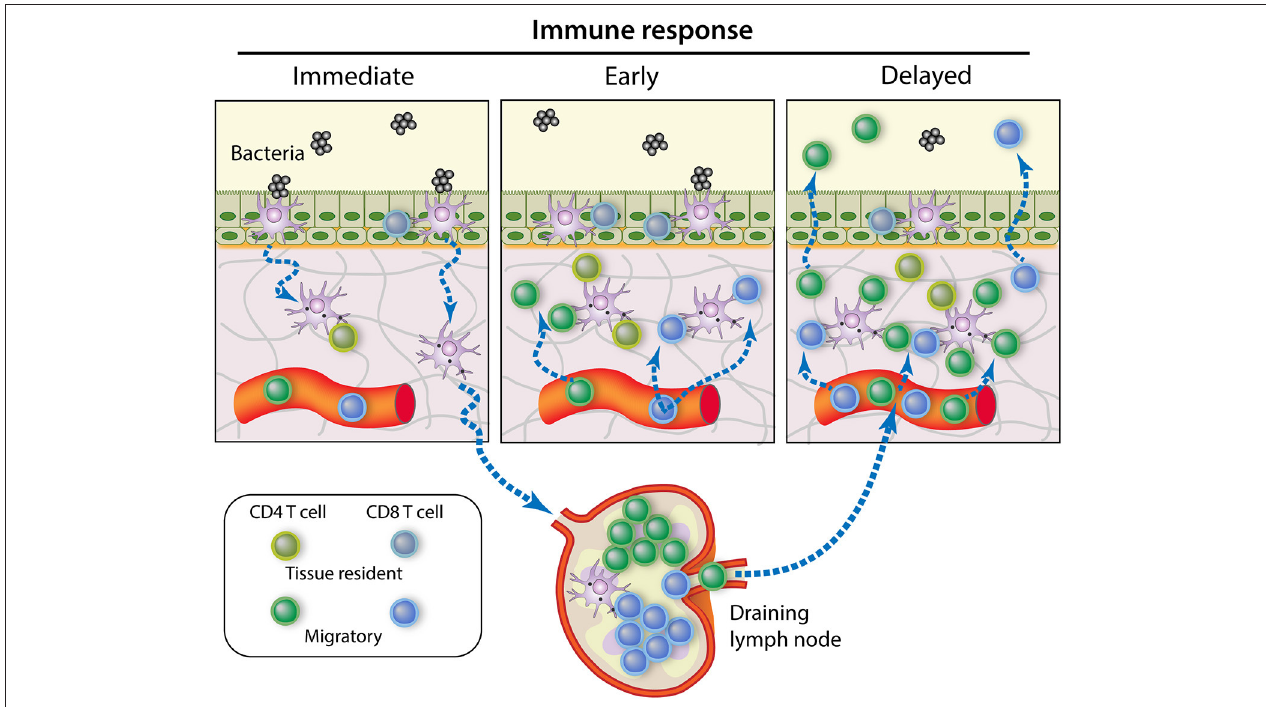
FIGURE 3 | Contribution of memory T cell subsets to the control of MG infection. Immediate response to pathogen intrusion is achieved by memory T cells present in the tissue at the onset of infection, namely the resident memory T cells. If the infection is not cleared at this stage, the early local inflammation recruits circulating memory T cells that amplify the immune response. Meanwhile, bacterial antigens are presented by APCs migrating from the infected tissue to the draining lymph nodes, where central memory T cells begin to proliferate and generate new effector T cells. After a few days, these effector T cells will migrate to the site of infection in great numbers, making a delayed but robust contribution to pathogen control [Modified from